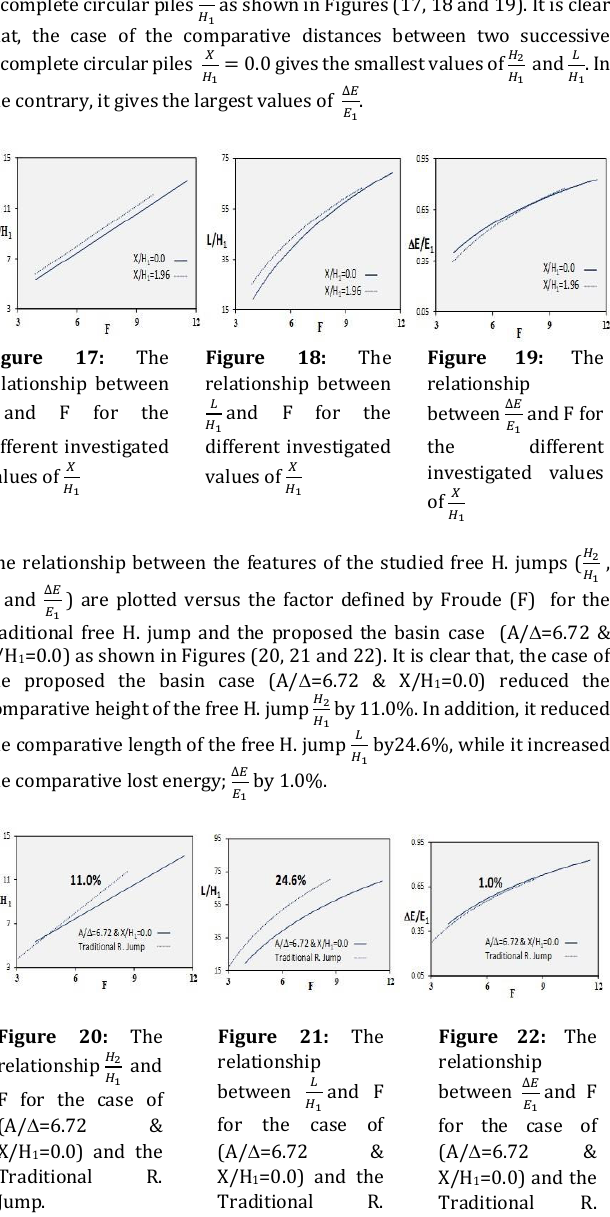
Figure 16: The relationship between ∆𝐸 and F 𝐸 1 for the different investigated values of 𝐴 ∆